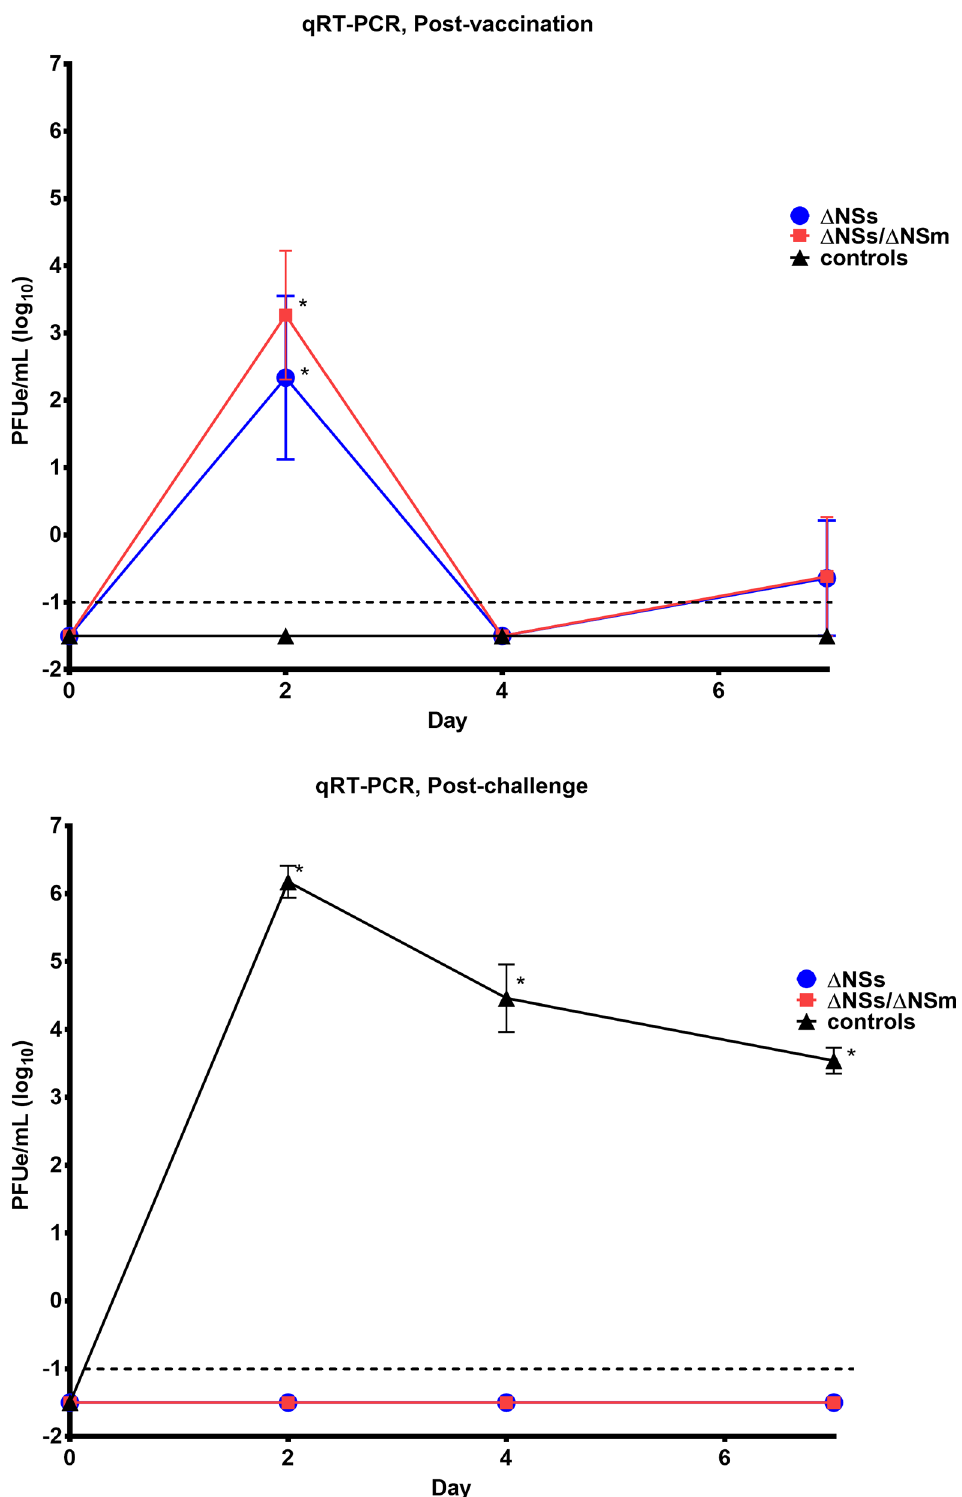
Fig 3. Viremia determined by qRT-PCR in marmosets post-vaccination (top) and post-challenge (bottom). RNA detected by qRT-PCR in marmosets post-vaccination (top) with rZH501- Δ NSs(n = 6), rZH501- Δ NSs- Δ NSm (n = 6), or sham inoculated controls (n = 5) and post-challenge (bottom) with 6 log 10 PFU of the virulent strain ZH501.